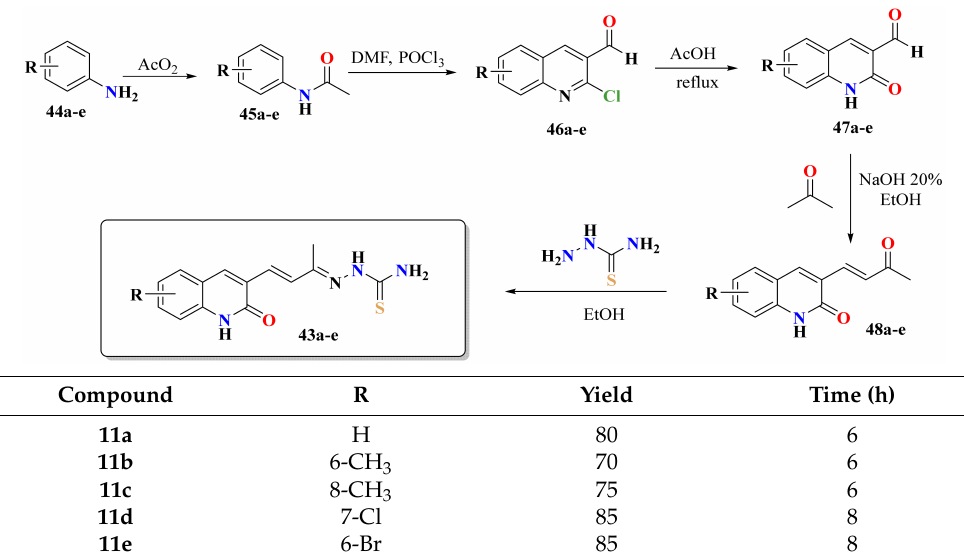
Table 7. General approach for the preparation of the target quinolinone-thiosemicarbazone hybrids 11a – e